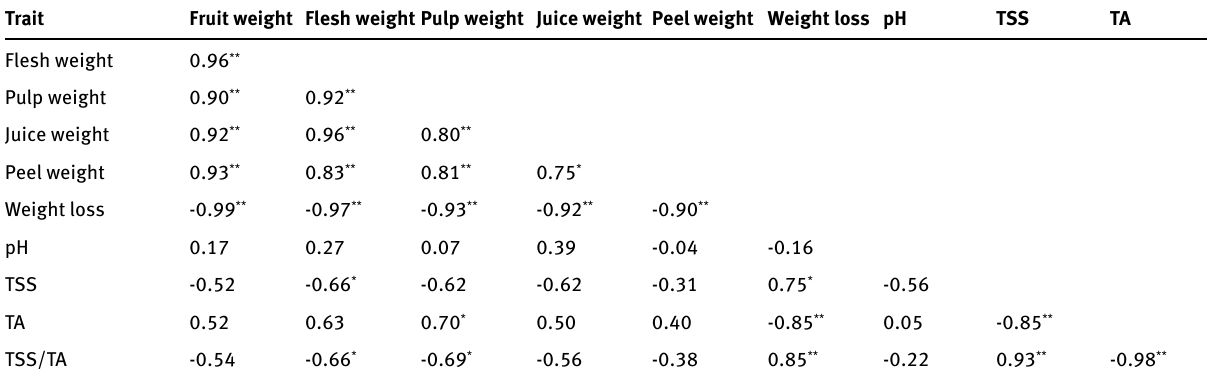
TATSSpHWeight lossPeel weightJuice weightPulp weightFlesh weightFruit